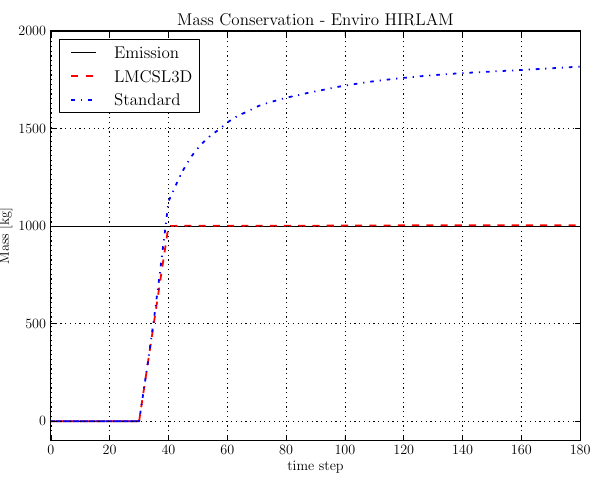
Fig. 5. Mass conservation. The traditional SL scheme shown by the dot-dashed (blue) line and the LMCSL-3D scheme shown by the dashed (red) line. The horizontal line indicates the true emitted amount.